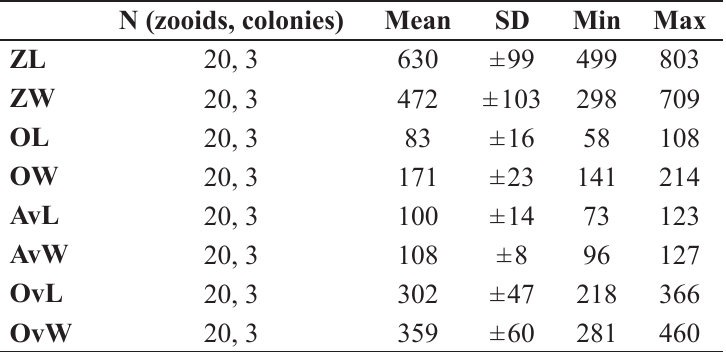
Table 8. Measurements in µm of Microporella modesta sp. nov., Recent, Foveaux Strait, New Zealand; holotype NHMUK 1869.10.6.6a, paratypes NHMUK 1869.10.6.6b,